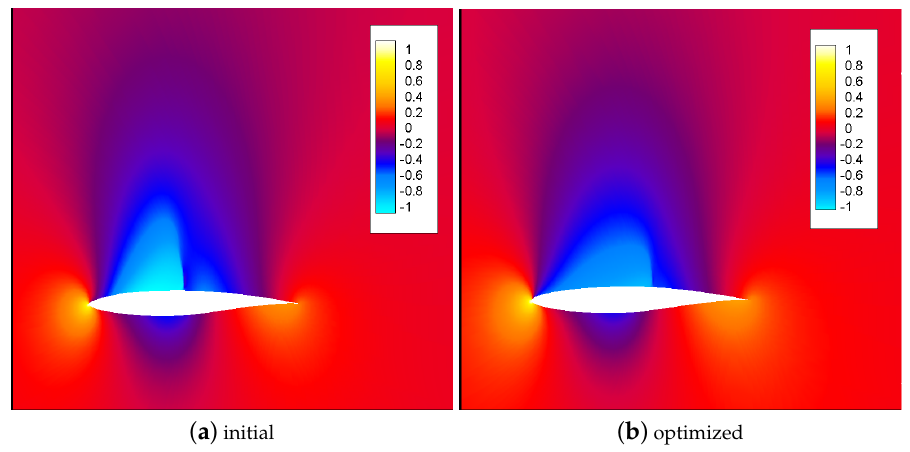
Figure 9. The comparison of the two optimization processes when the case of improved design requirement formulation has converged to the Pareto front.